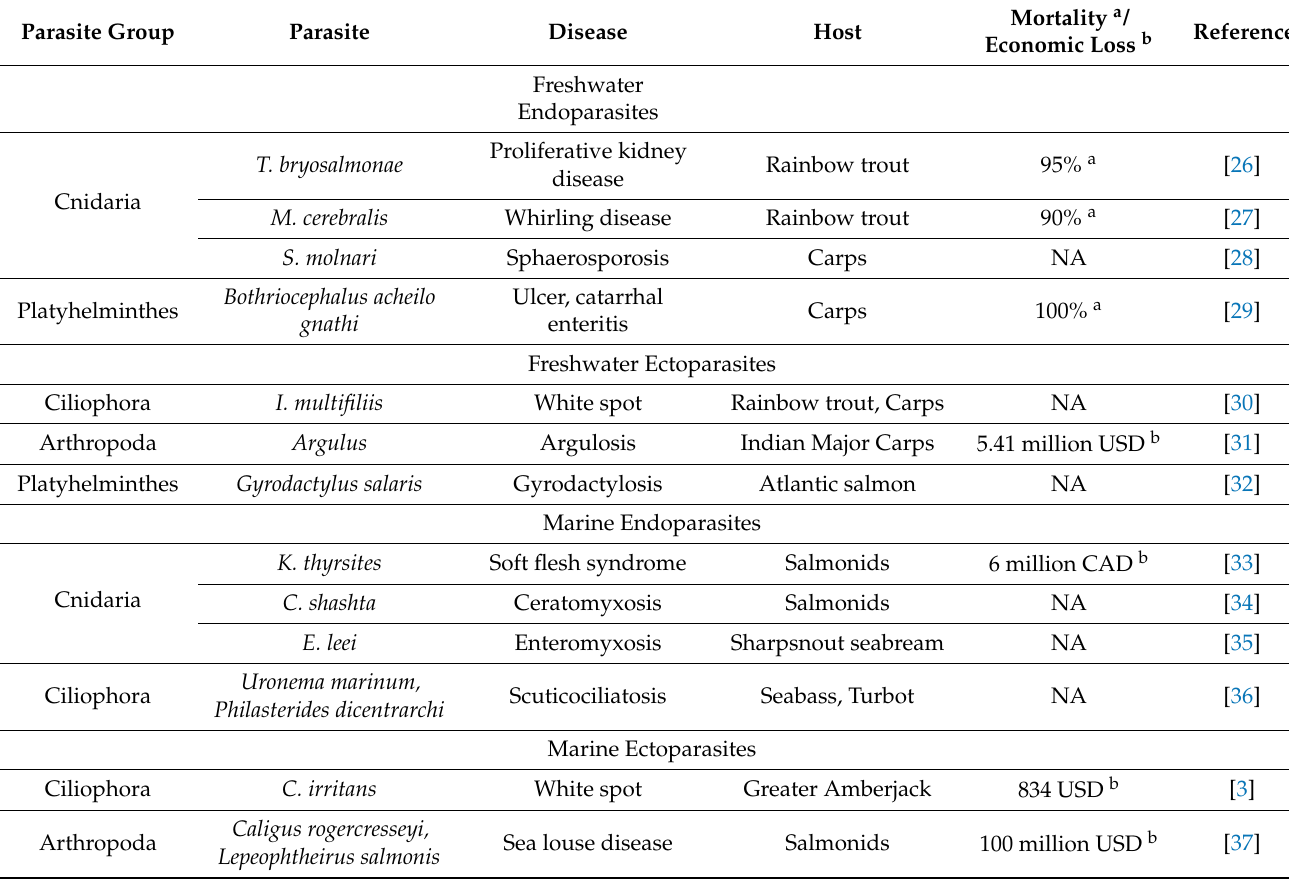
Table 1. Some economically important fish parasites: Table provides information on mortality and economic loss caused by important parasites of fish. NA: not available, a: mortality, b: economic